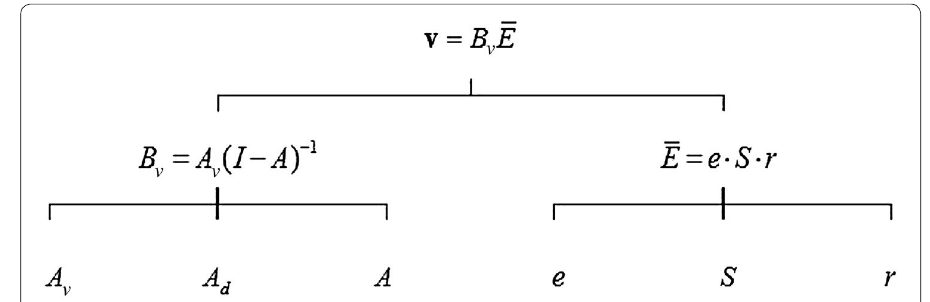
Fig. 1 Hierarchical decomposition of exported